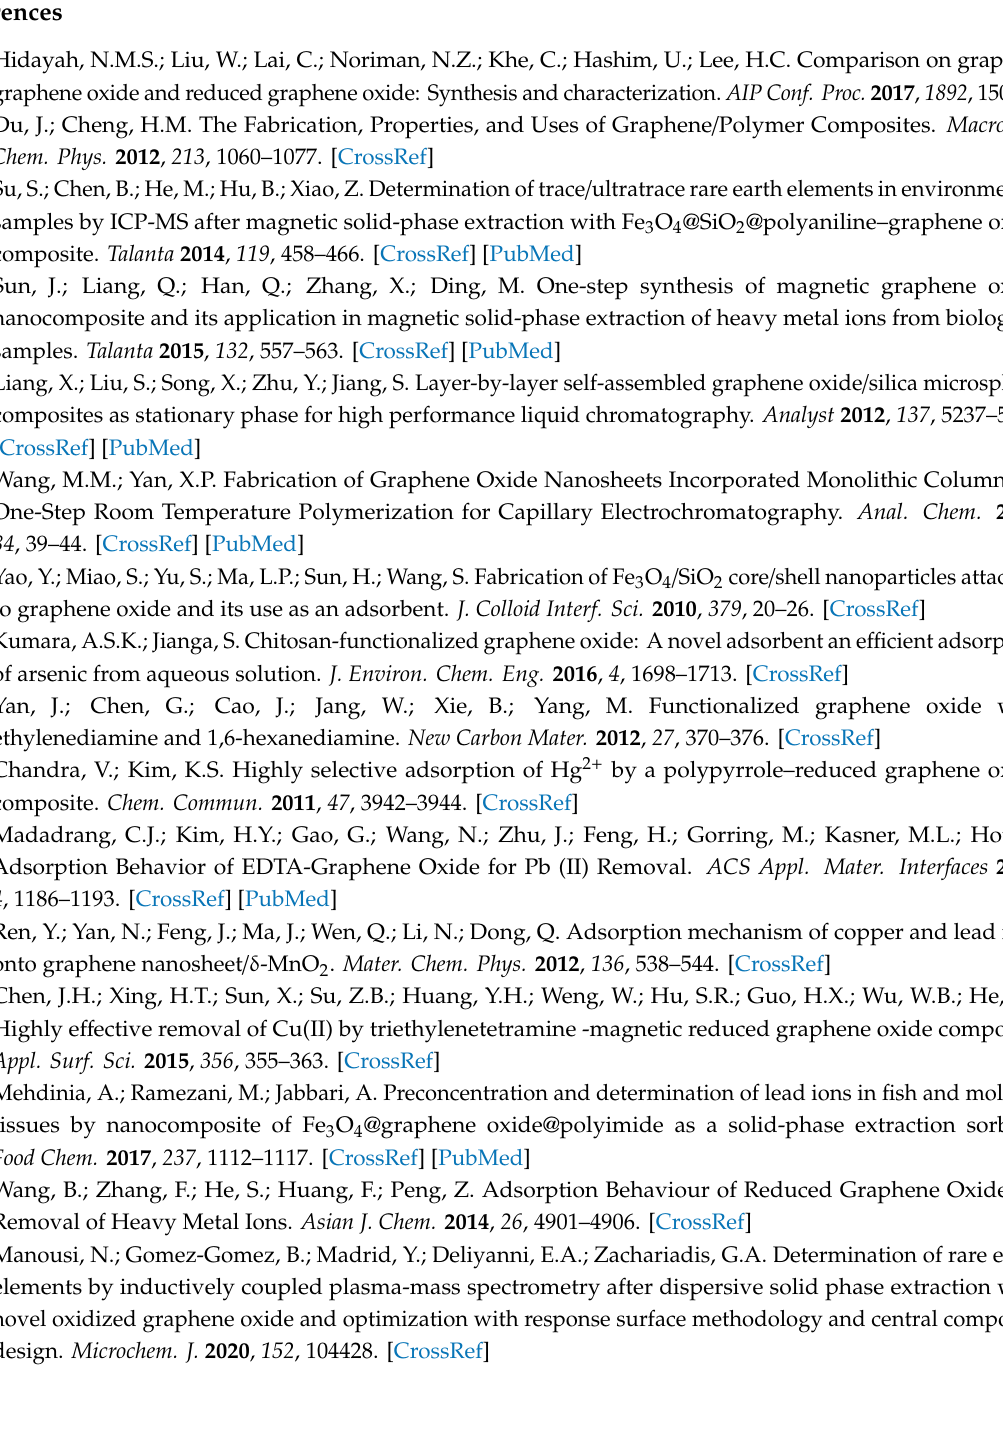
Table S3: Regression analysis of the examined toxic and nutrient metals using full factorial design, Table S4: Comparison of the proposed method with other